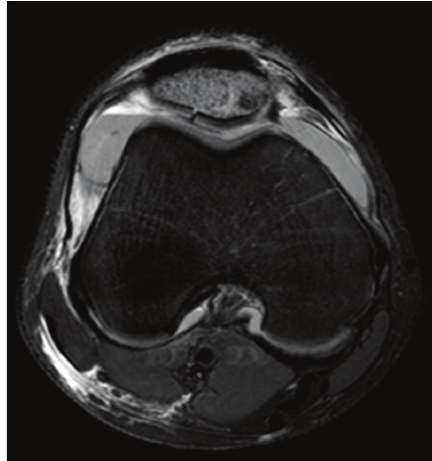
Figure 2: Axial T1 weighted magnetic resonance image taken one week after presentation.